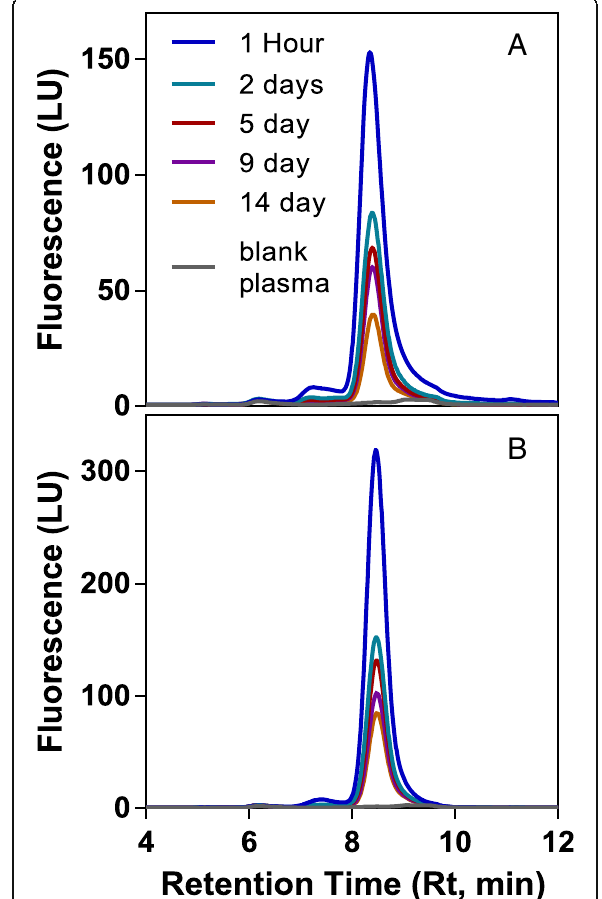
Fig. 13 In vivo stability of Pep-ADC ( a ) and unconjugated mAb3 ( b ). Shown are the fluorescence SEC-HPLC profiles of the DyLight650 labeled antibodies at indicated time points in plasma of C57BL/6 J mice after a single 3 mg/kg IV administration. The plasma samples were run on a BioSep-SEC-S3000 column at 1 mL/min elution rate with PBS as a mobile phase for 15